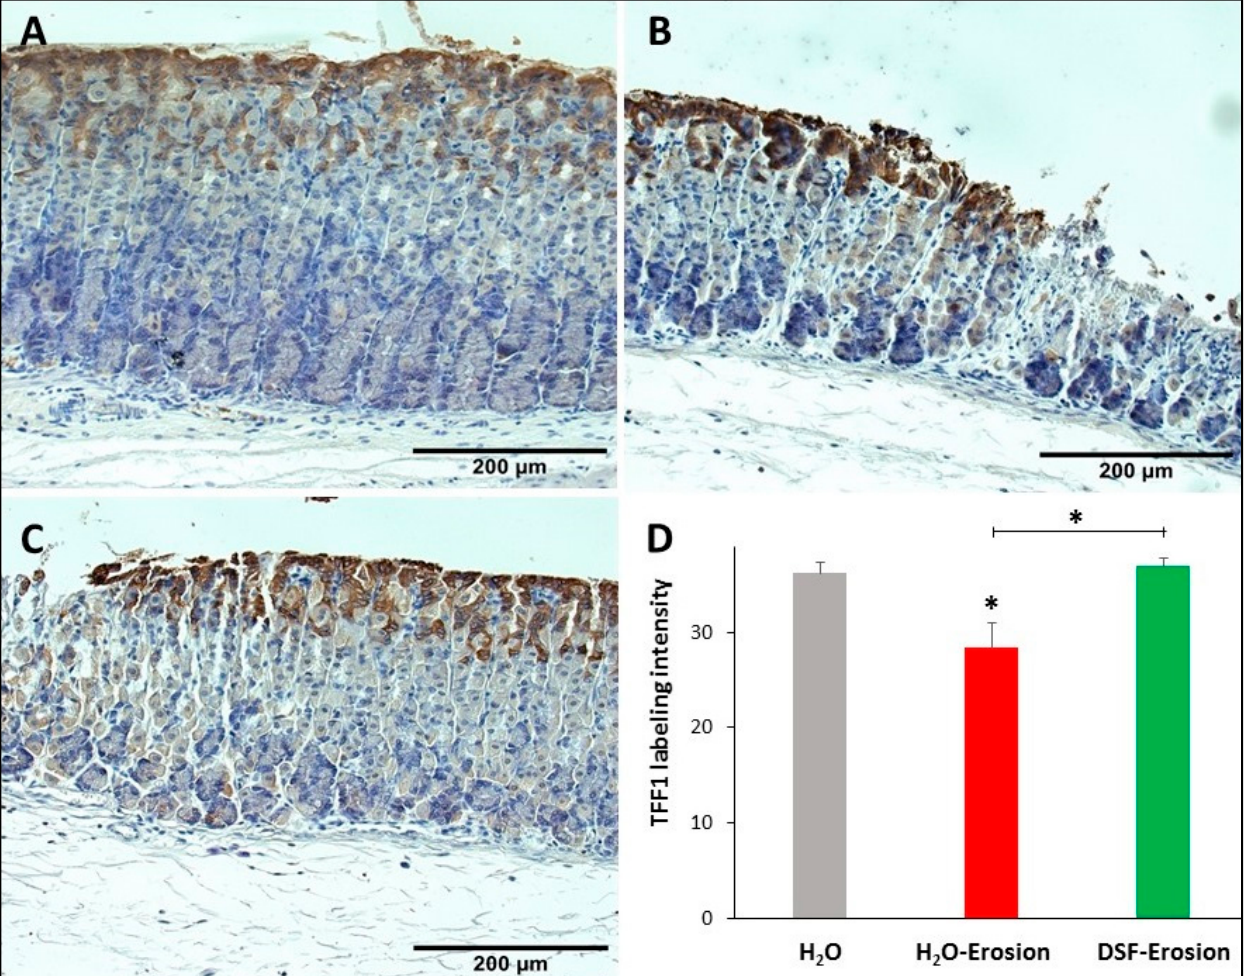
Figure 7. TFF1 immunolabeling in the gastric mucosae of H 2 O control ( A ), erosion-induced ( B ) and DSF-erosion ( C ) mice. The tissue sections were counterstained with hematoxylin. Brownish TFF1-labeled cells are seen at the luminal surface and in the pit regions. ( D ) Quantifications of TFF1 labeling intensity is calculated from three mice in each group and presented as mean ± SE. * p < 0.05; scale bar = 200 µm.